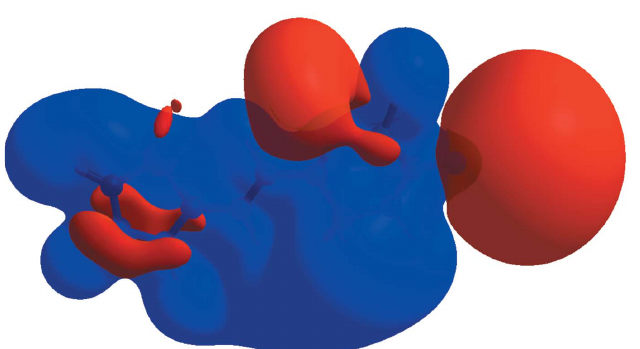
Figure 7 The total electron density three-dimensional surface mapped for the compound with the electrostatic potential calculated at the B3LYP/6– 31G(d,p)